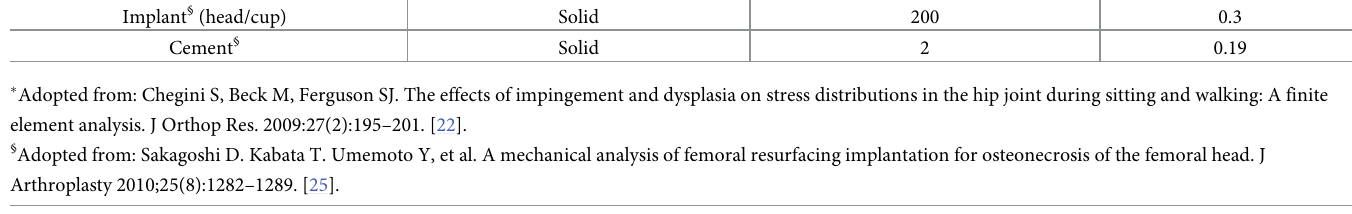
determinant in assigning the type of elements and their material properties. The cortical bone was meshed with 3-node shell elements with a uniform thickness of 1.5 mm, as previously described by Chegini et al, and filled with 4-node tetrahedral elements to represent cancellous bone [22]. The BHR implant and cement were meshed with 8-node hexahedral elements. In order to mesh the relatively thin implant (mesh it with several layers) and to manage the aspect ratio of the elements, we had to use very small size elements. The very fine mesh of this model made the mesh size effects negligible. There was no slippage between the femur, cement, and implant [23]. The cup was also secured to the acetabulum to restrict slippage. A surface-to-sur- face contact was considered between the outer surface of the head and inner surface of the cup with 80 μ m of clearance [21]. This clearance was determined by property of contact element. The contact was defined by pairing two surfaces. When they got close to each other, at a defined distance of 80 μ m, contact was detected. This was the initial distance that contact was initiated due to presence of fluid between the femoral head and acetabular cup. In addition, a frictional coefficient of 0.15 was considered between surfaces [24]. The cortical and cancellous bone were considered homogeneous (uniformly distributed density) with isotropic linear elas- tic material behaviour (Table 1). The polymethyl methacrylate (PMMA) bone cement mantle and cobalt-chrome implant were modelled as isotropic linear elastic materials. The model did not account for movement through the sacroiliac joint or the pubic symphy- sis. These joints were fully constrained for the purpose of this study. The femur on the other hand, was kept free to move during loading. A concentrated load was applied to a reference point defined at the center of the femoral head (Fig 1). The applied load was adopted from in- vivo data of the peak hip contact force for three different loading conditions (Table 2): single